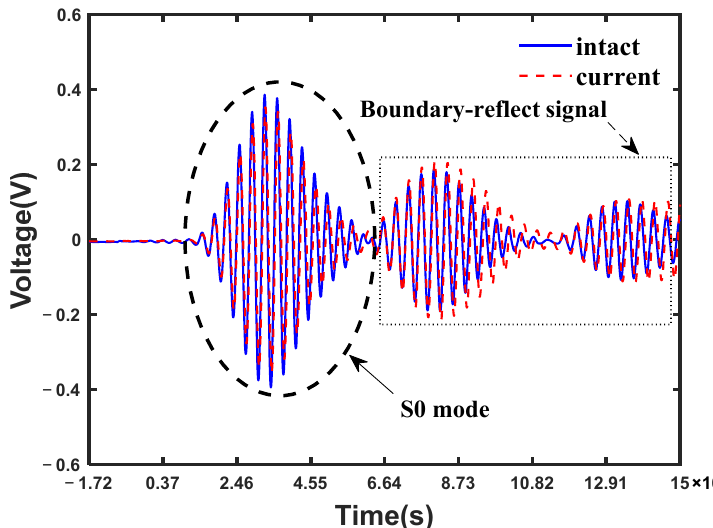
Figure 5. Typical waveforms of signals received from the sensing path AB in the intact (blue line) and the current (red dashed line) state, respectively.